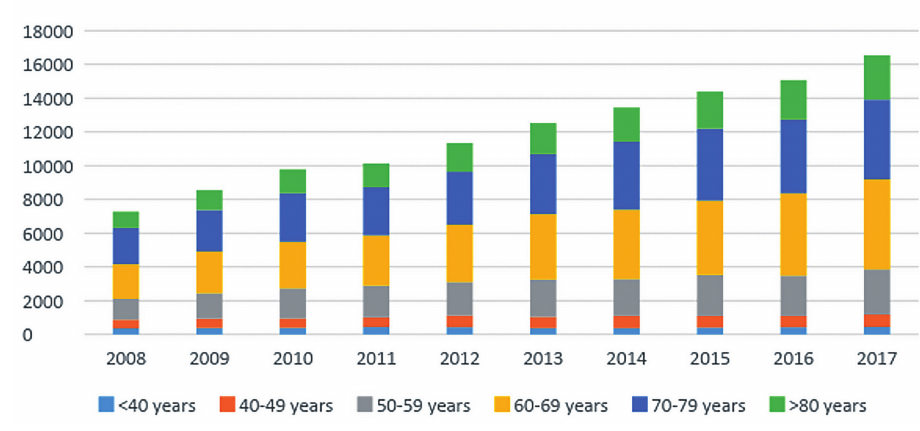
Figure 3 - Bladder Cancer admissions according age group (2008-2017).